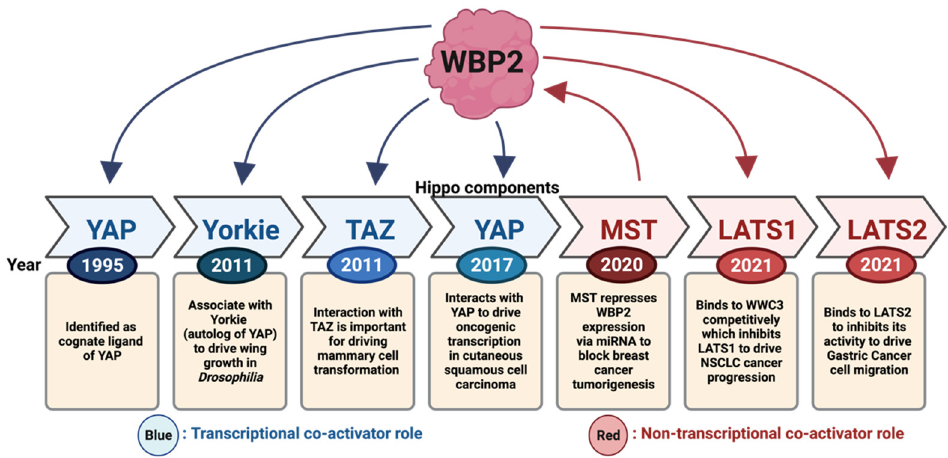
Figure 5. Schematic timeline of WBP2 implication in the Hippo pathway. WBP2 was first discovered to interact with YAP in 1995. Later in 2011, it was shown to promote growth in Drosophila by associating with Yorkie. In the same year, its oncogenic role affecting the Hippo pathway was first implicated in breast cancer through its association with TAZ. The oncogenic role of WBP2 in directing Hippo dysregulation was later extended to other cancer types including cutaneous squamous cell carcinoma (cSCC), non-small cell lung carcinoma (NSCLC) and gastric cancer. The Hippo pathway regulating WBP2 levels was identified to be through the Dicer–miRNA axis by MST. The text coloured in blue describes the transcriptional co-activator role of WBP2 in the Hippo pathway through binding to YAP and TAZ. The text coloured in red describes a non-transcriptional co-activator mechanism of WBP2 in the Hippo pathway. The arrow indicates the direction of regulation (i.e., WBP2 on Hippo/Hippo on WBP2). Created with BioRender.com .